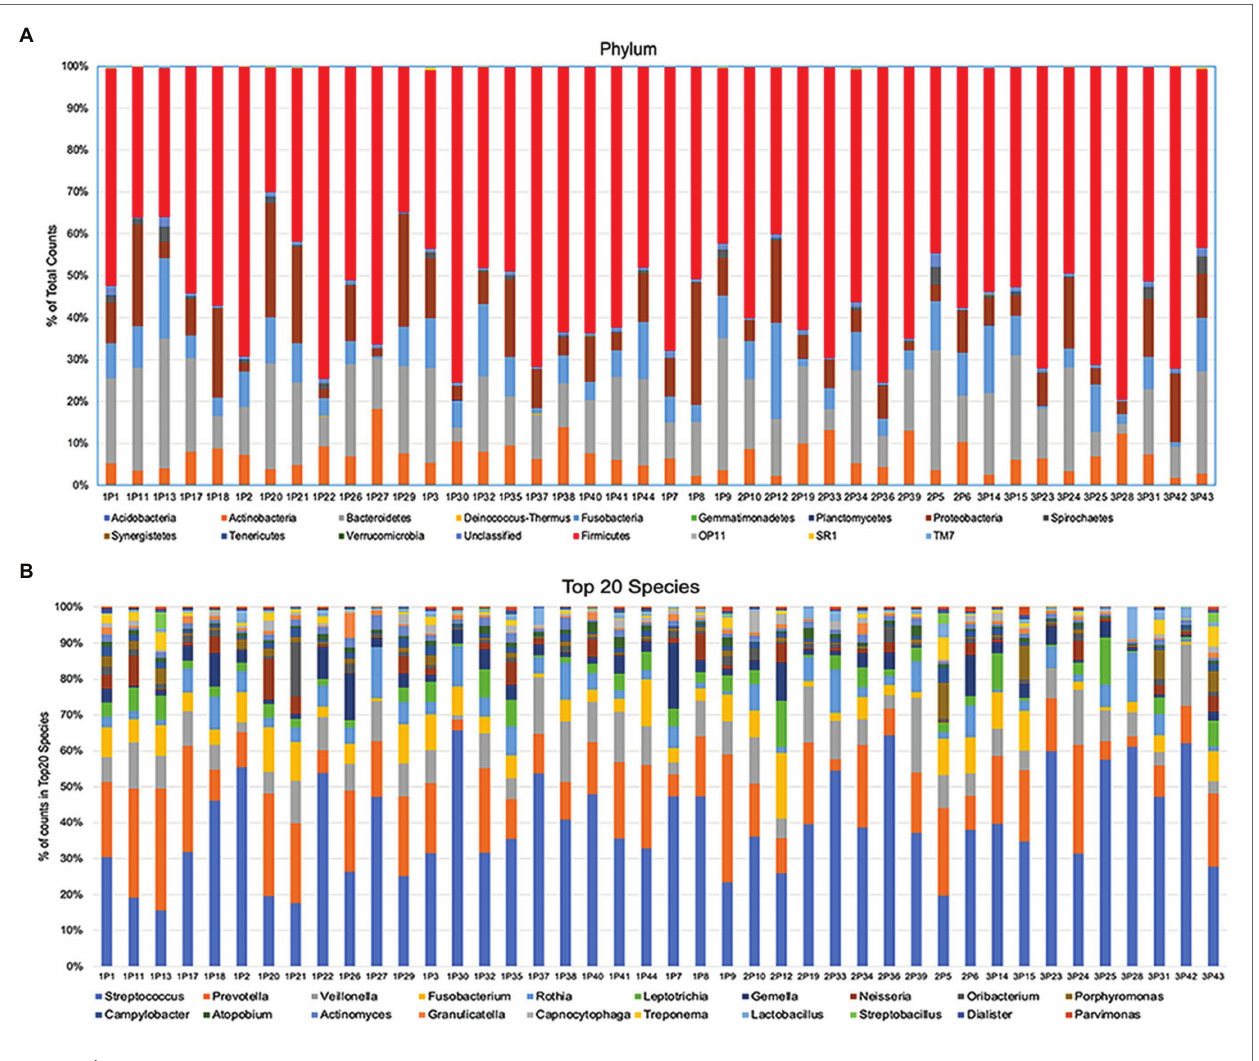
FIGURE 1 | The components of microbiome at the phylum or species level from individual samples.